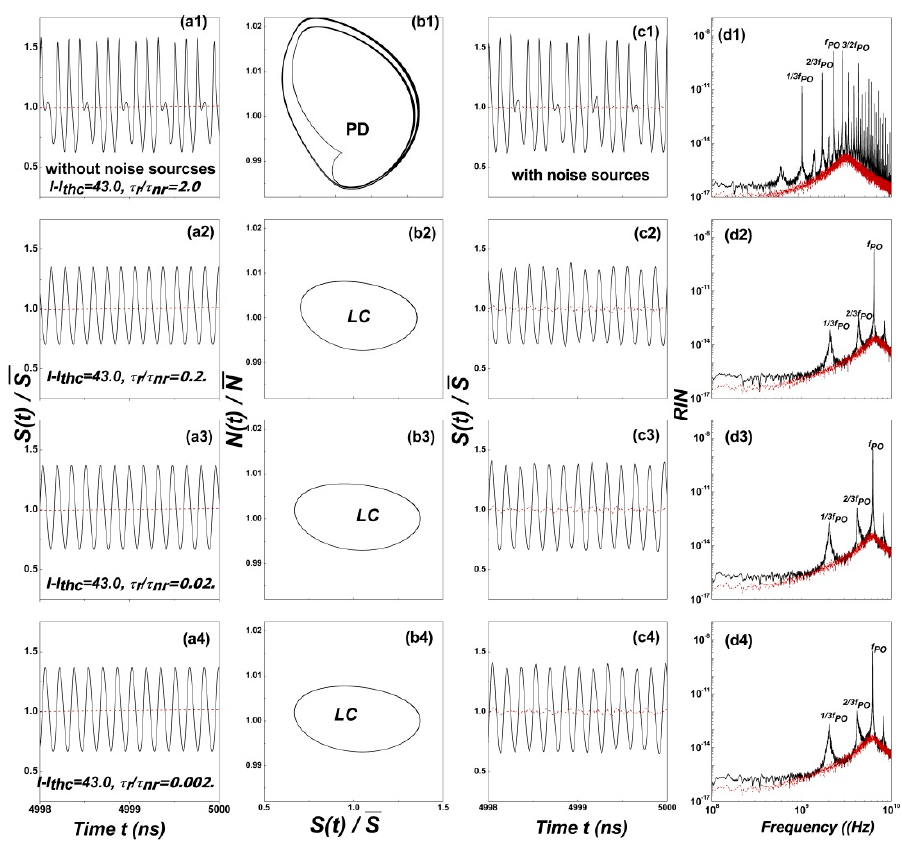
Figure 6. Time, phase portraits and RIN of photon number S ( t )/ S of an SL at route to chaos point, when ( I - I thc ) = 43.0 mA and τ r / τ nr = 2.0, 0.2, 0.02, and 0.002 (first route to chaos).